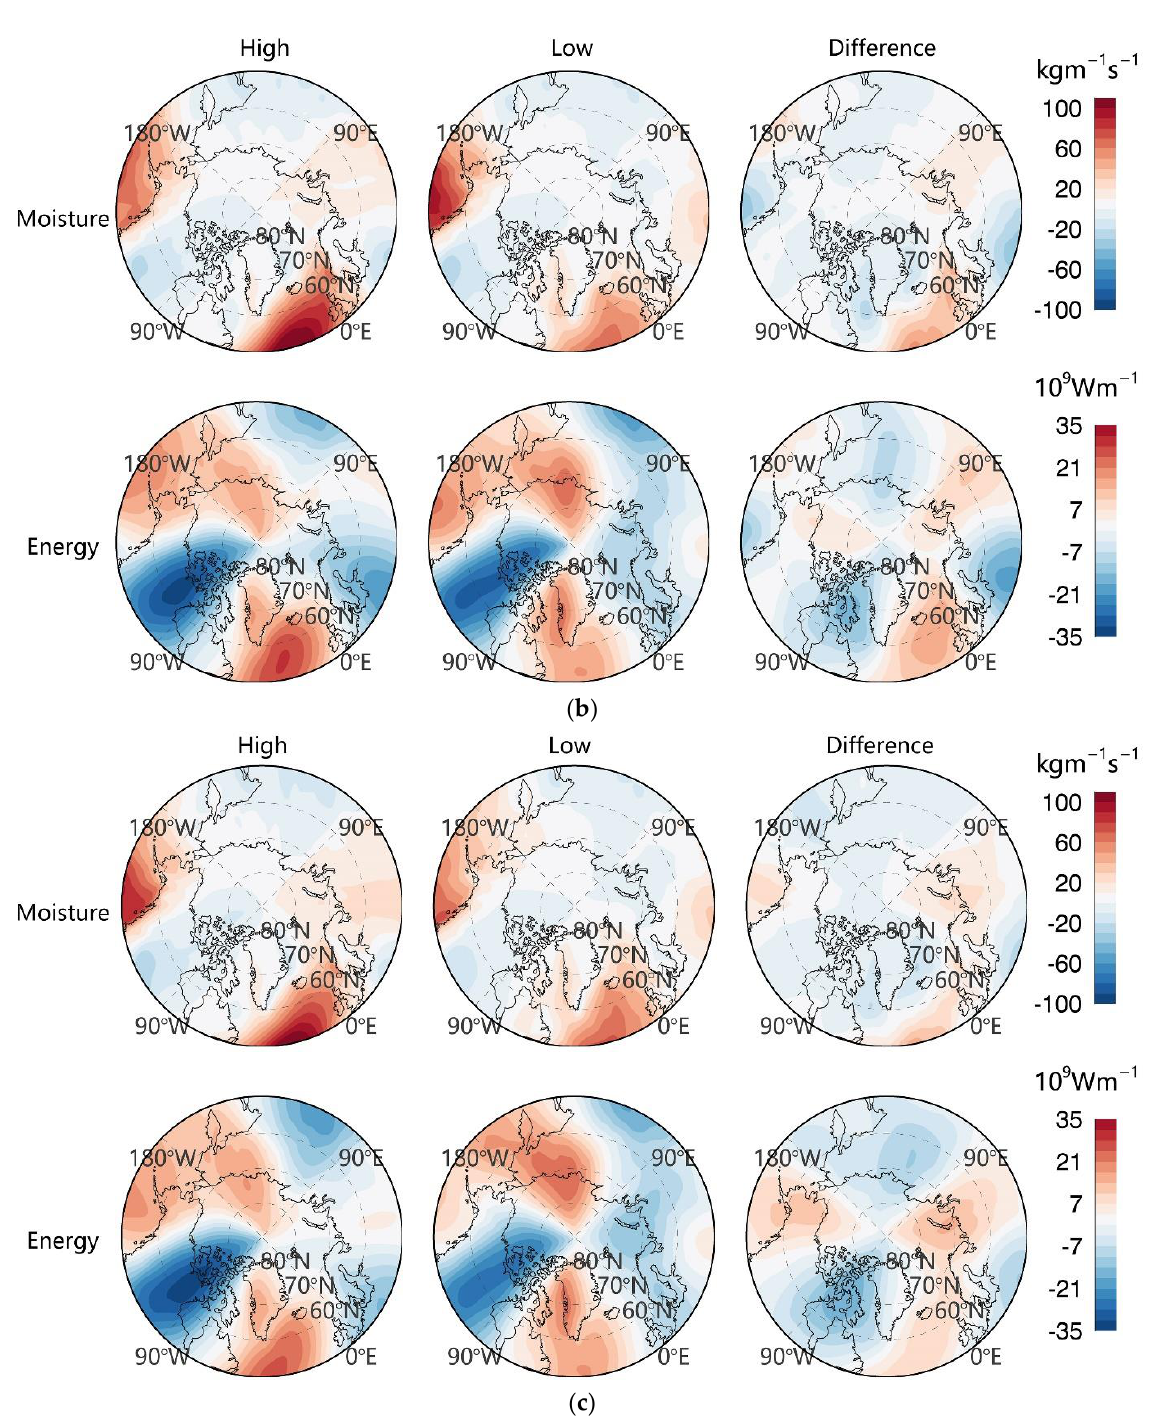
Figure 6. Composite analysis of meridional moisture flux and energy flux from ERA5 over the Arctic region based on the most positive and negative large-scale atmospheric circulation indices and their differences: ( a ) AO, ( b ) NAO, and ( c ) DA.